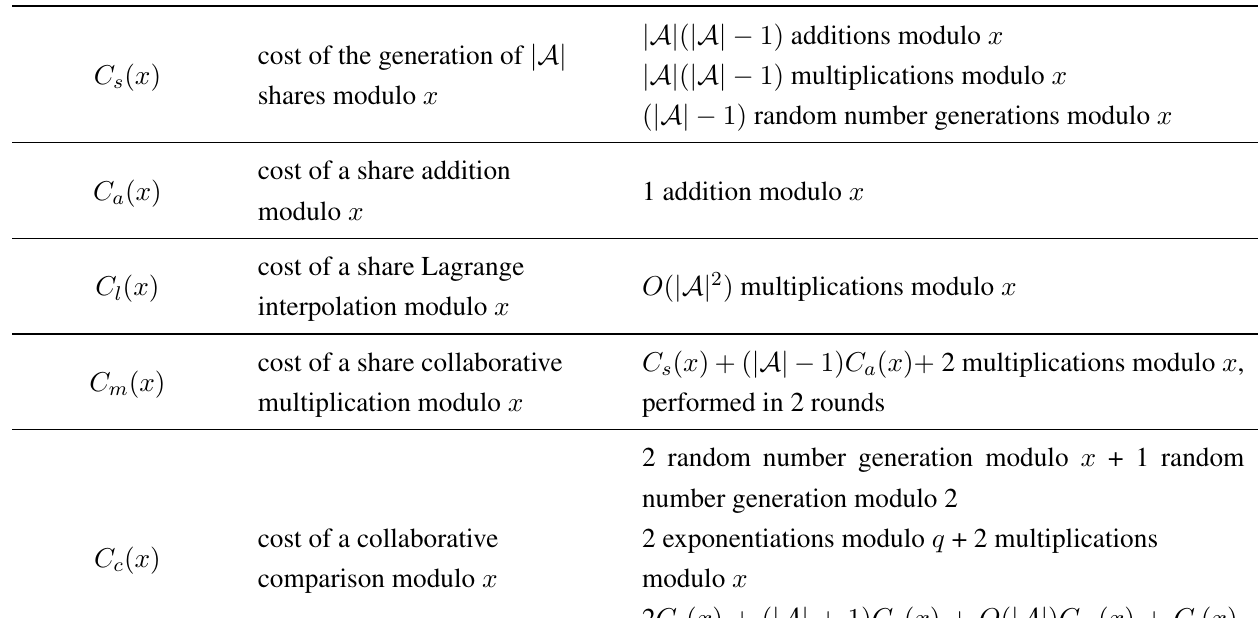
Table 4. Detail of operation